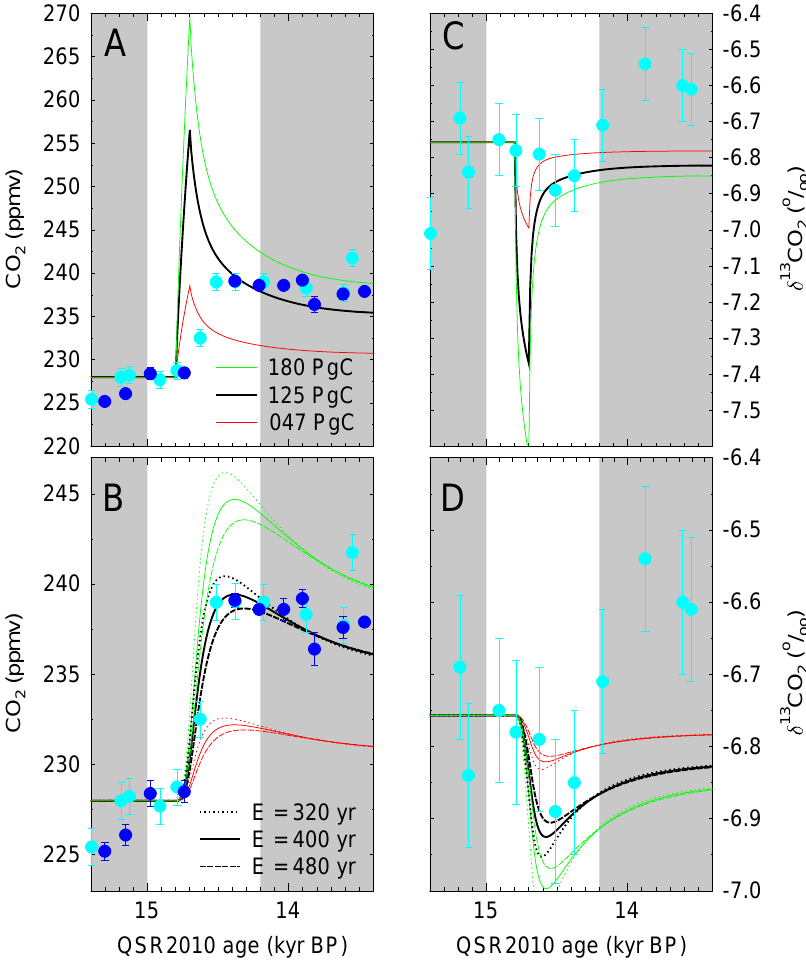
Fig. 5. Influence of (i) the amount of carbon injected in the atmosphere and of (ii) the details of the gas age distribution on both the atmospheric signal and that potentially recorded in EDC. The amount of carbon injected in the atmosphere (A, C) covers the range derived from an airborne fraction f between 12 and 45% from 47 to 180PgC with our reference scenario of 125PgC in bold. Injections occurred in 100 yr with terrestrial δ 13 C signature. In the filter function of the gas age distribution (B, D) the width E varies from 320yr to 480yr, our best-estimated gas age width E at the onset of the B/A of 400yr in the solid line, representing the range given by the firn densification model including heat diffusion ( Goujon et al., 2003), as plotted in Fig. 3. Only the dynamics between 15.0 and 14.2 kyr BP (white band) are of interest here and should be compared with the ice core